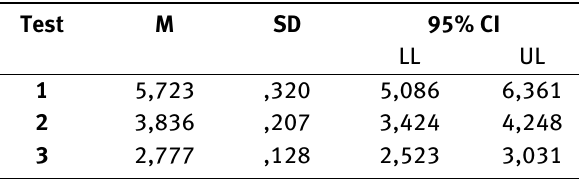
Table 1: Average test-dependent Take Over reaction time (incl. confi- dence intervals), N = 95.